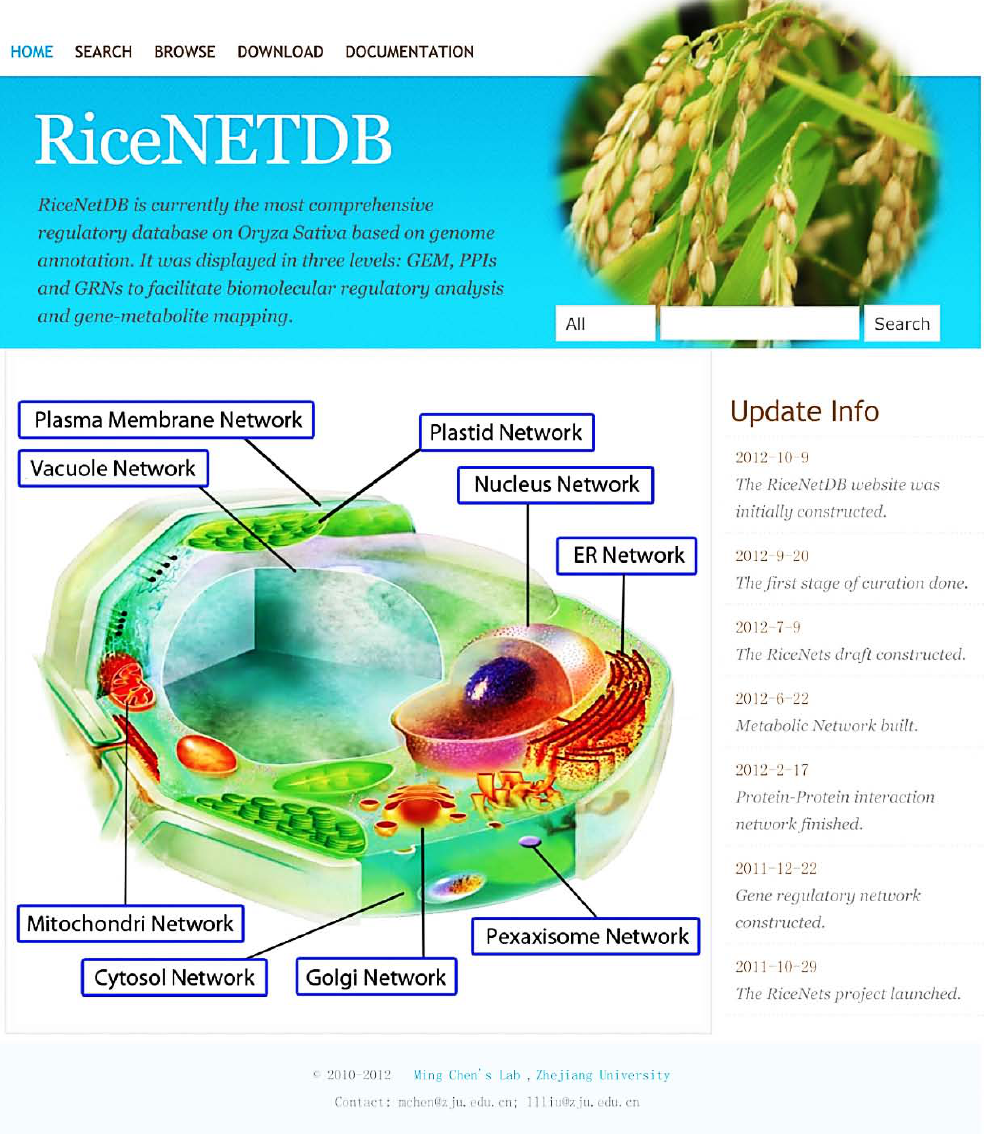
Figure 2: The RiceNetDB website screenshot. A public accessible version of RiceNetDB is scheduled to release later